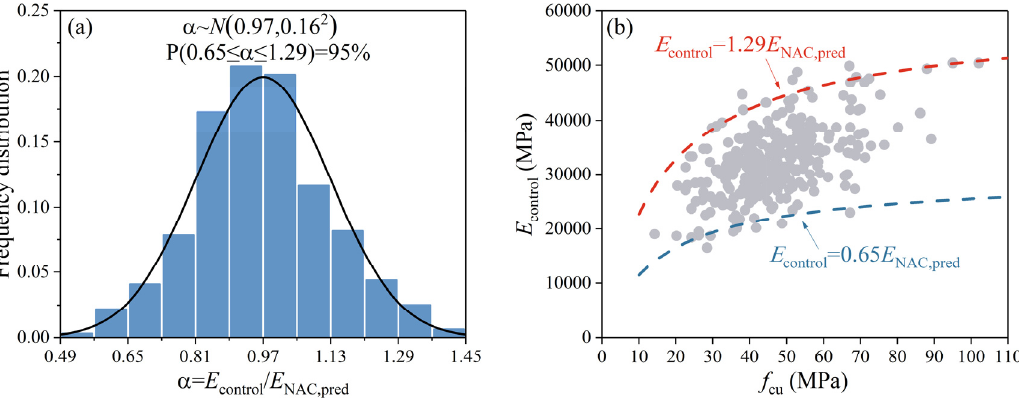
Figure 2. Distribution of α and E NAC [21,22,28–174]. ( a ) α ~ N (0.97,0.16 2 ); ( b ) 1.29 E NAC,pred ≥ E NAC ≥ 0.65 E NAC,pred .